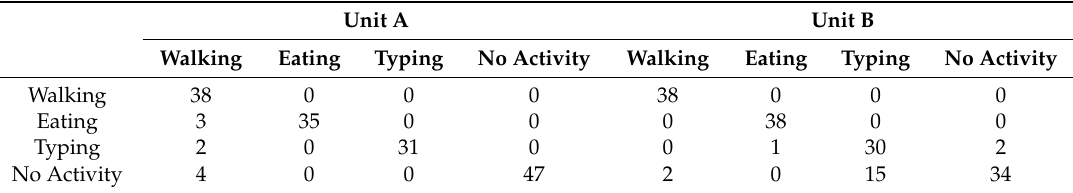
Table 1. Confusion matrix for Unit A and Unit B using SVM-based model (Data shown here represent 40% of garnered data).